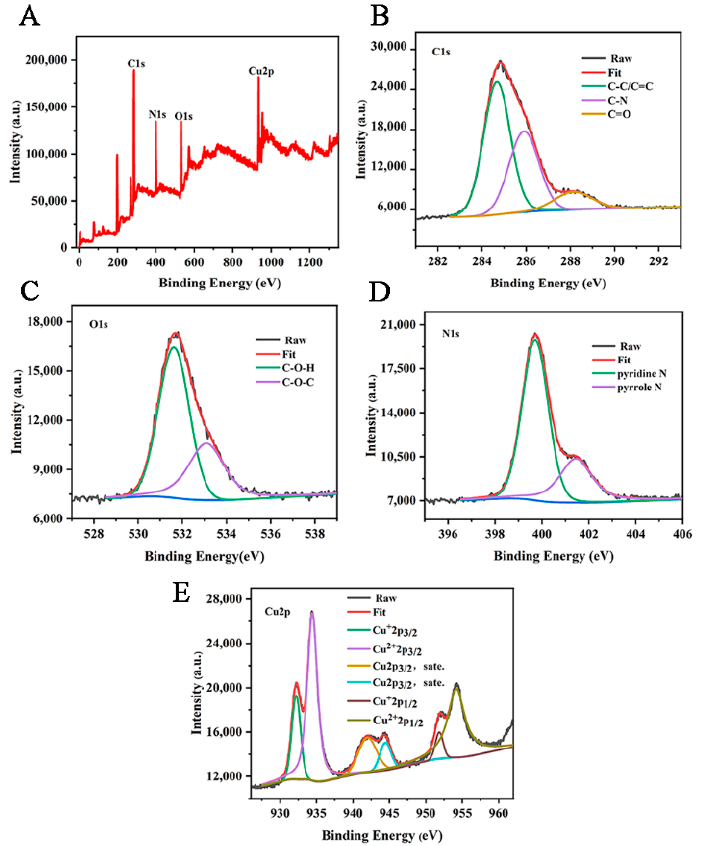
Figure 4. ( A ) XPS full-spectrum scan and high-resolution spectra of C 1s ( B ), O 1s ( C ), N 1s ( D ) and Cu 2p ( E ) of Cu-CDs.